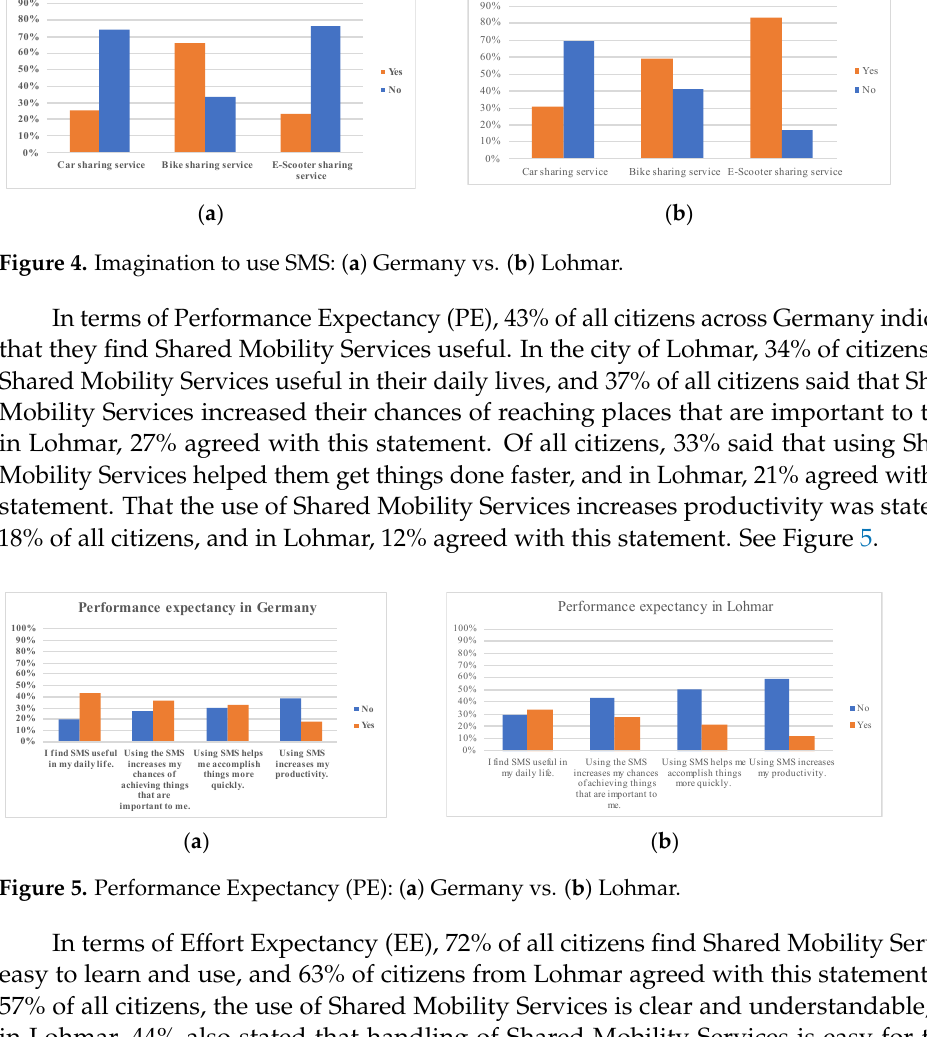
( b ) Figure 3. Experience with SMS: ( a ) Germany vs. ( b ) Lohmar.